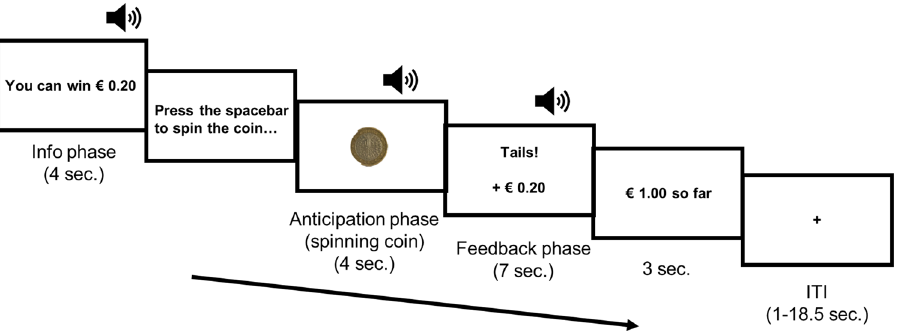
Figure 1. Overview of the task. The “head or tails paradigm” started off with an information screen indicating whether money could potentially be won or not (information phase). Next, participants pressed the spacebar to start a movie clip of a spinning coin (anticipation phase). This phase was followed by a feedback screen indicating whether the coin landed on heads or tails and how much money was won accordingly (feedback phase). Finally, an overview was given of the money won so far. Trials were separated by an intertrial interval (ITI) ranging between 1 and 18.5 s, to allow spacing of subsequent startle probes within the range of 25.25– 33.25 s. Startle probes were delivered either during the information- (24 probes), anticipation- (24 probes) or feedback phase (48 probes; 12 per win potential and outcome condition). Note that unlike during the information- and anticipation phase, participants do know both win potential and trial outcome during the feedback phase. Therefore, the number of conditions/startle probes in each phase (before feedback (information and anticipation phase) and after feedback (feedback phase) is unequal. The amount of money at stake was either 0 Euro or a fixed amount of 1 cent, 5 cent, 10 cent or 20 cent, and was dependent on the reward magnitude group a participant was assigned to. The coin in this figure is only for illustrative purposes and not the actual coin shown to